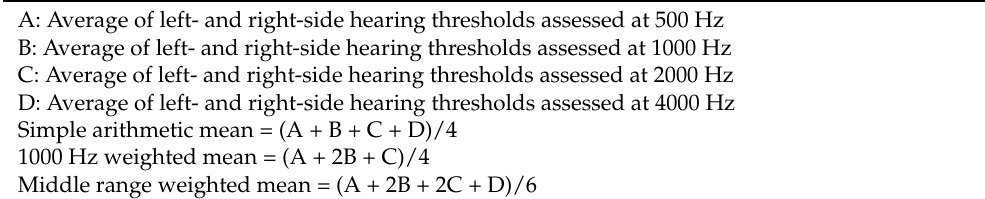
Table 1. Method for calculating average hearing threshold from individual pure-tone audiometry tests at four